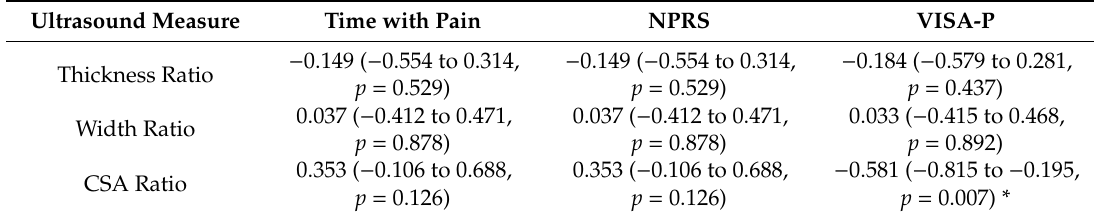
features in non-elite sport players with unilateral patellar tendinopathy.